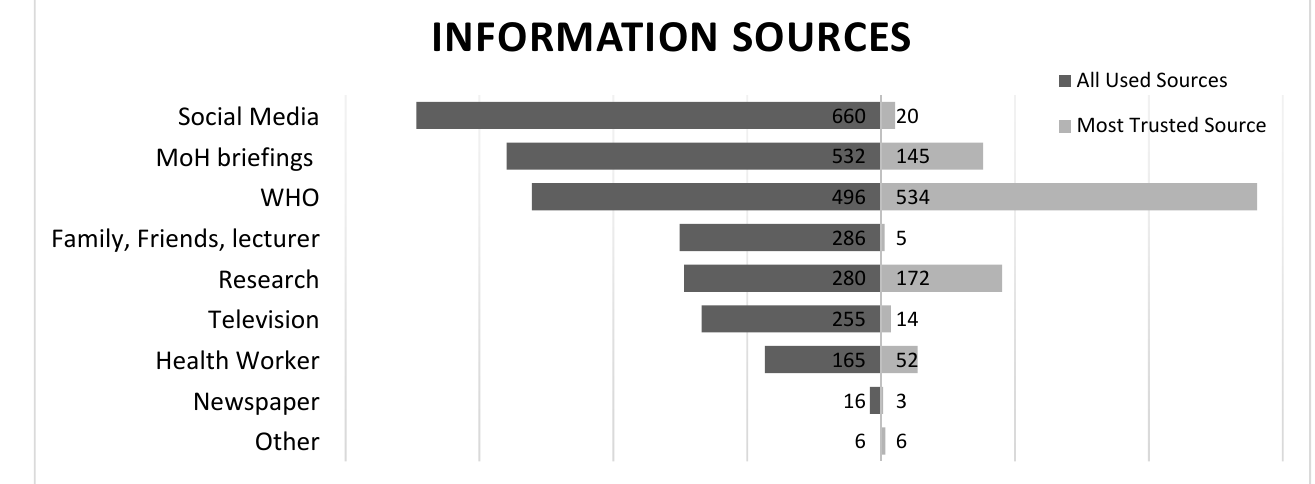
Figure 2. The most frequently used information sources and the most trusted sources. Note that the sum of the information sources used does not equal 951 (the total population), because it was calculated by a “check ‐ all ‐ that ‐ applies” question, so a respondent who chose multiple answers would be counted multiple times. The most trusted source was a one ‐ answer ‐ only question.